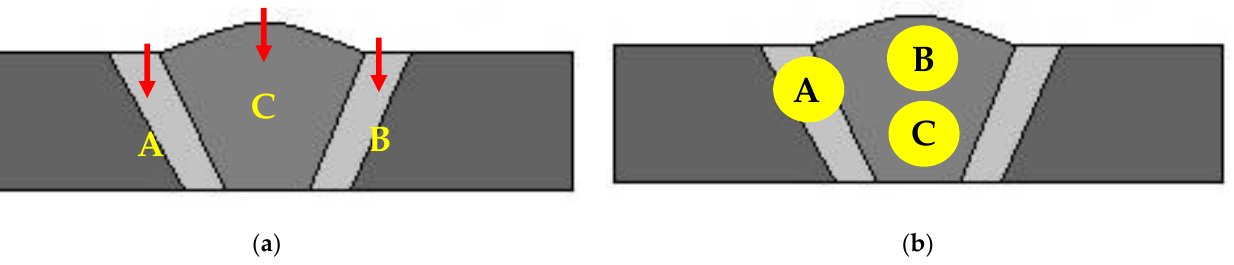
Figure 4. Measurement positions on weld specimens. ( a ) Microhardness measurement positions; ( b ) Residual stress measurement positions.